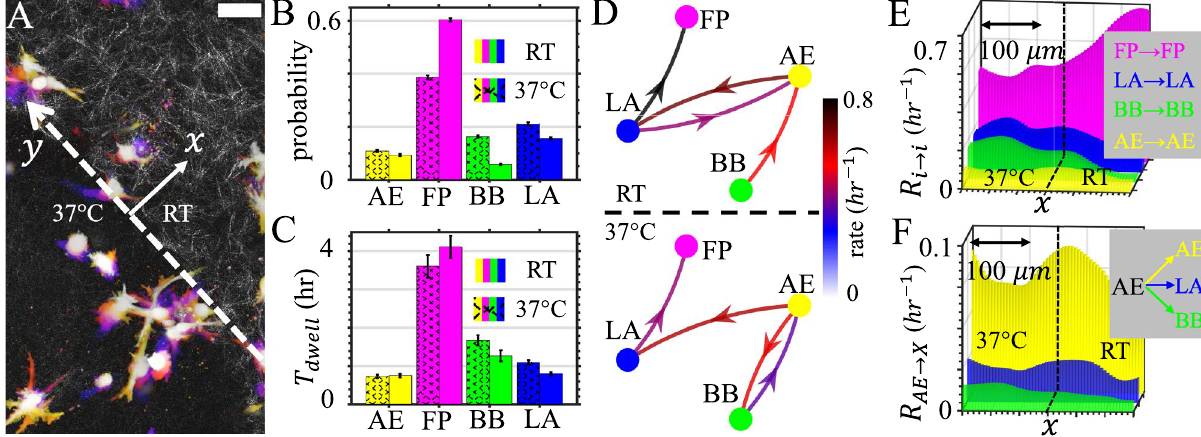
Figure 6. Morphological phenotype transition facilitates cell migration in heterogeneous ECM. ( A ) Time-lapse projection of 3D migrating MDA-MB-231 cells navigating engineered heterogeneous ECM. The ECM contains ◦ two adjacent layers that are prepared at room temperature (RT) and 37 C respectively. A confocal reflection image shows the ECM structure next to the interface (dashed line, y -axis). Scale bar: 50 µ m. ( B ) Fraction of cells of each morphological phenotype in both sides of the interface. ( C ) Dwell time of cells of each morphological phenotype in both sides of the interface. ( D ) Phenotype transition rates in both sides of the interface. ( E ) Spatial frequency of of dwell events. ( F ) Spatial frequency of AE to AE, AE to LA and AE to BB events. See main text for the definition of spatial frequency R ( i → j , x ) . In ( E, F ) dashed lines indicate the interface ( x =0) separating ◦ the 37 C gel (left) and RT gel (right). A total of 3800 h of single cell recordings from three